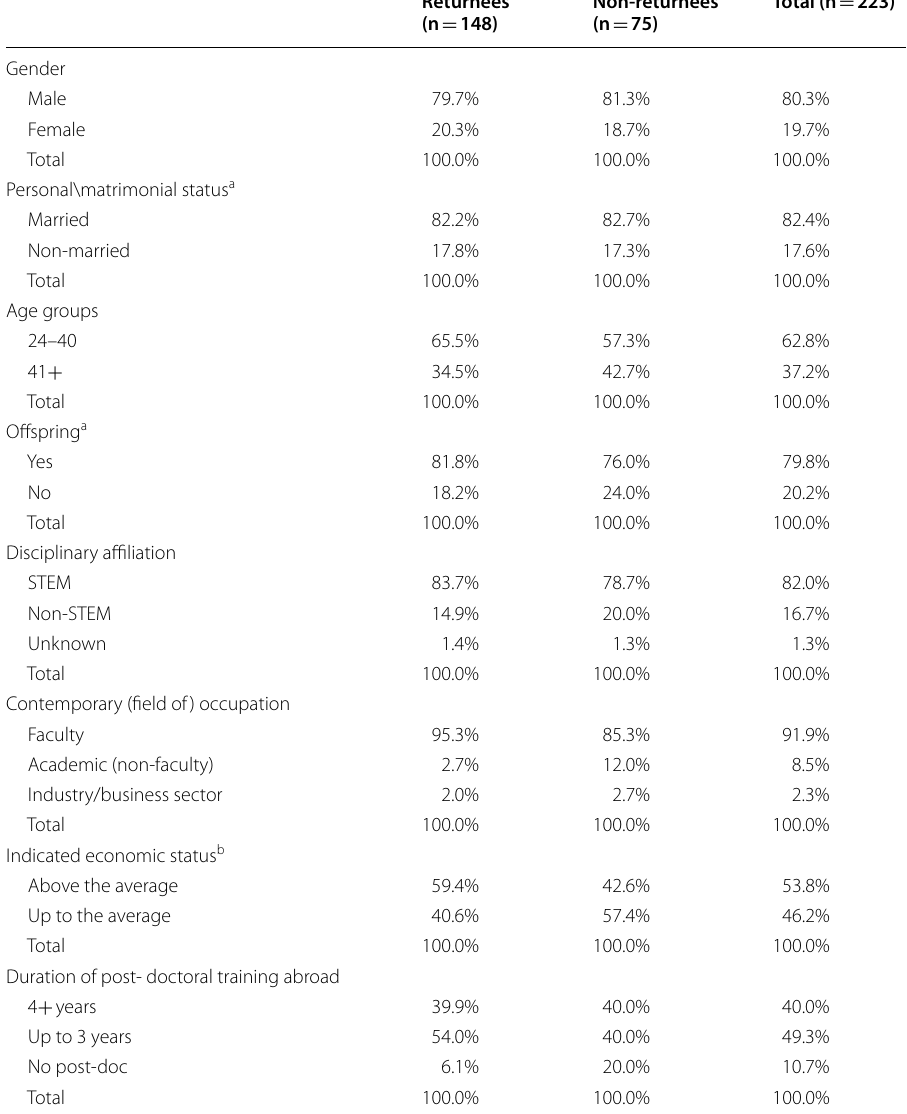
Table 1 Socio-economic, demographic, and professional profile of the sampled ECRs—returnees and